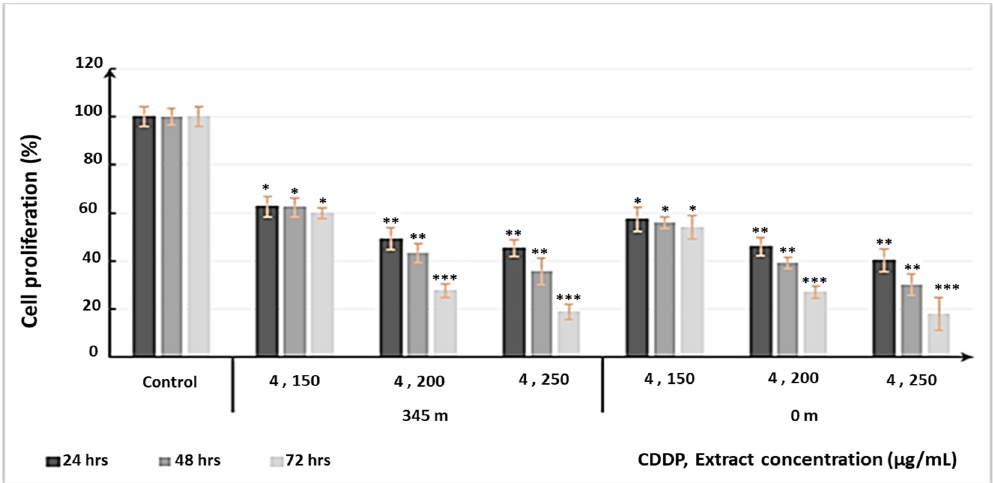
Figure 9. Cell proliferation of A549 cells after exposure to gradually increasing concentrations of Cisplatin and ethanolic extract for 24, 48, and 72 h. Peak values are represented as mean +/ − SD. Statistical analysis: Paired t test or Wilcoxon test. * p < 0.01; ** p < 0.01; *** p < 0.001 in which percentage of proliferation of treated cells is compared with that of control at 24, 48, or 72 h.